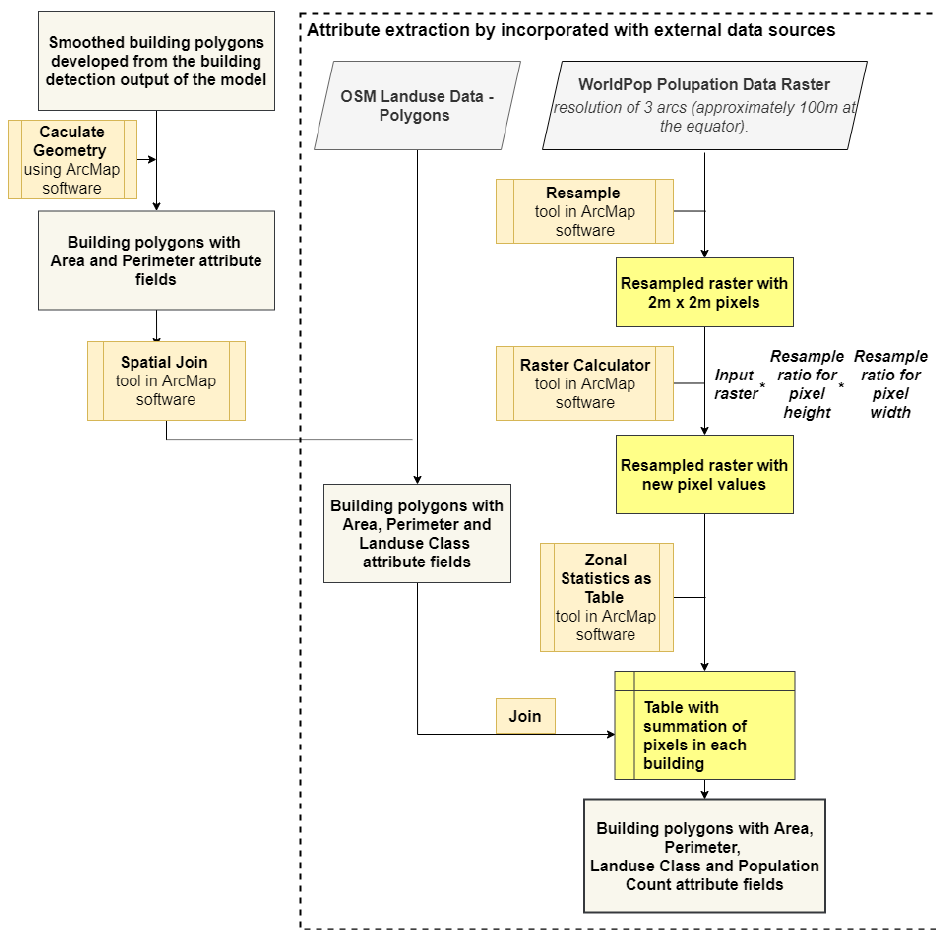
Figure 6. Proposed methodology for attribute extraction process.